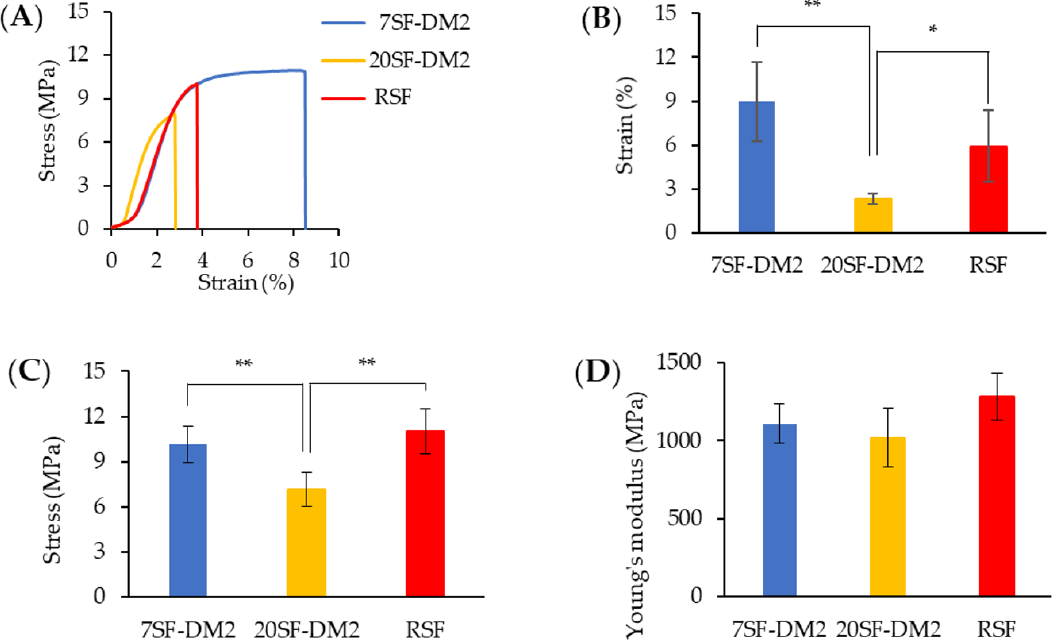
Figure 6. Tensile tests of SF nanofiber nonwoven mat electrospun from fractionated SF aqueous solution: ( A ) Typical stress–strain curve; ( B ) Influence of MW of SFs on strain at breaking (** p < 0.01, * p < 0.05, n = 5 by Tukey–Kramer test); ( C ) Influence of MW of SFs on stress at breaking (** p < 0.01, n = 5 by Tukey–Kramer test); ( D ) Influence of MW on Young’s modulus. No significant differences among fractions and RSF were found by Tukey–Kramer test ( n = 5, p >